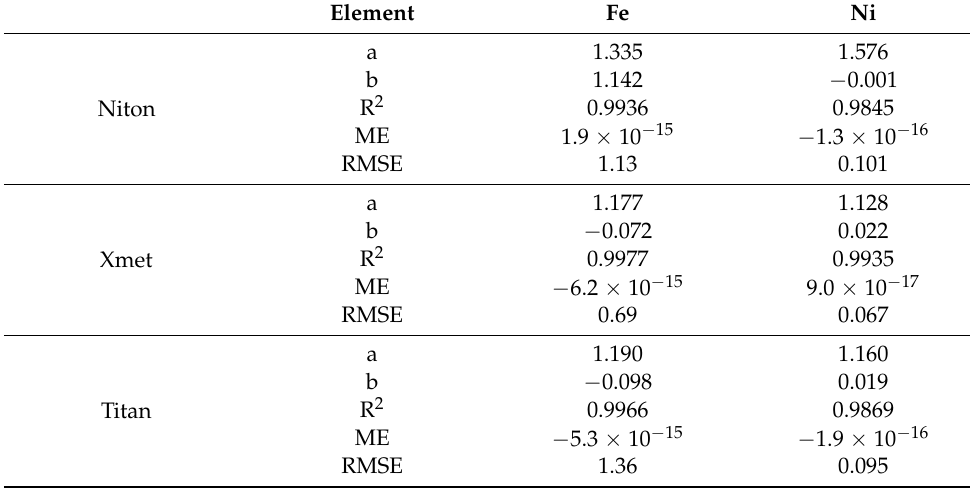
Table 6. Parameters of the linear regression between concentrations at higher water content and concentrations in dry sample for the two elements and for the three devices (a: Slope, b: y-intercept, R 2 : Coefficient of determination, ME: Mean error, RMSE: Root-mean-square error). Element